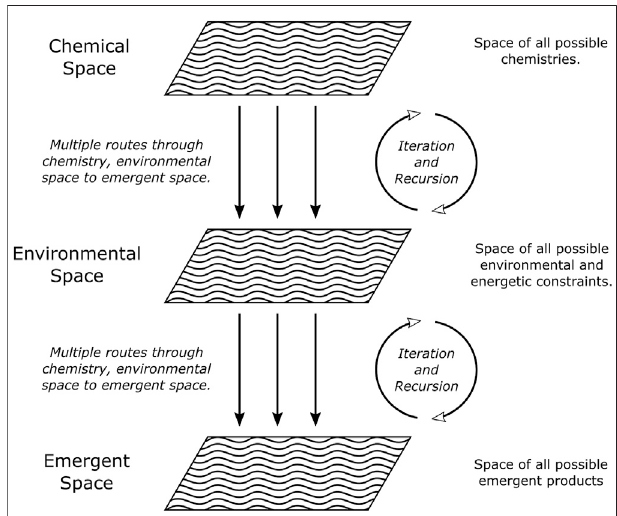
FIGURE 1 | Graphical representation of the systems astrochemistry concept highlighting the different levels of